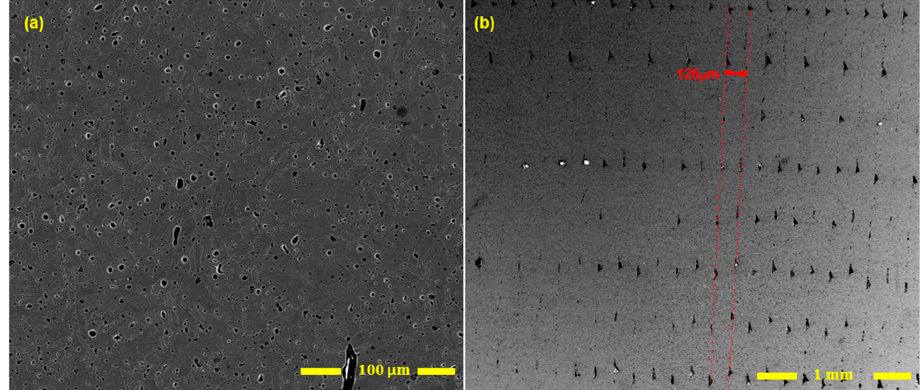
Figure 5. SEM images of the cross-section (Section A-A, Figure 3) of the polished and etched as- sintered part (V blocks, see Figure 4). ( a ) Voids in component and ( b ) voids at the layers’ interfaces (layers are in the shown direction, and the post-sintering layer thickness is 125 μ m). Note—the building direction is along the red arrow shown in ( b ). A smooth and mirror-finished surface is required for both sides of the ultrasonic bending fatigue test specimens. After cutting the test specimens, first they were polished using a single-wheel metallographic hand polisher. Then, the surfaces of the specimens were mirror-finished using a vibratory polisher. Before testing, the specimens’ thicknesses were measured at their gauge sections to calculate the induced stresses and verify uniform thickness throughout the samples [30].